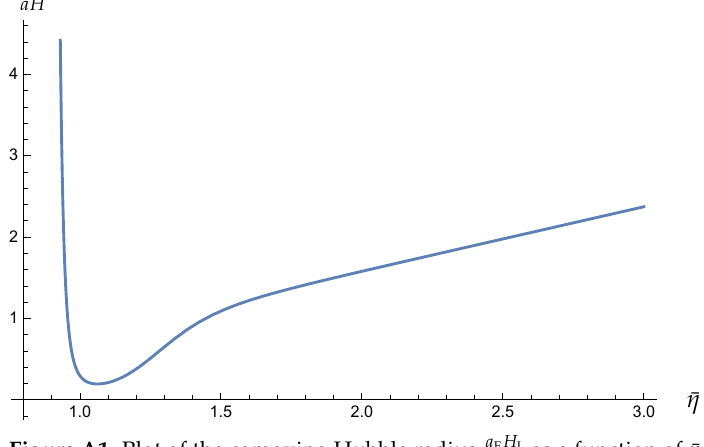
as a function of ¯ η aH